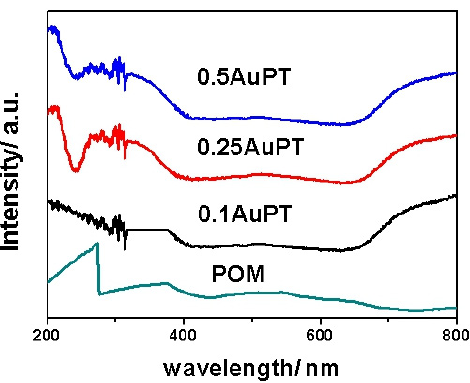
Figure 4. UV-visible diffuse reflectance spectra of POM and AuPT with different Au loadings.